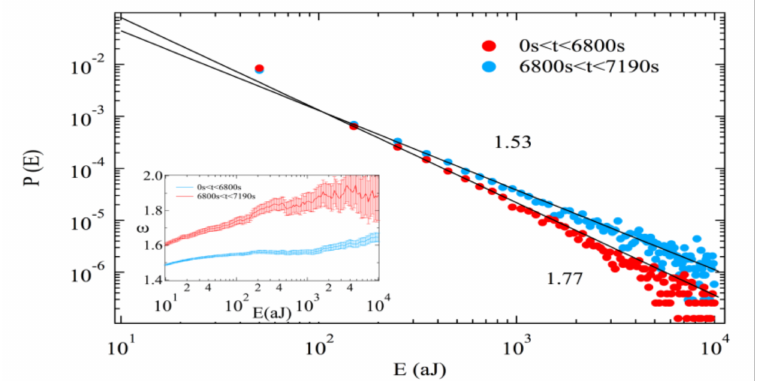
Figure 3. Distribution of avalanche energies for sandstone samples in the different time windows. The inset shows the maximum likelihood estimation fitting exponent ε as a function of a lower threshold. Reproduced with permission from [54]. De Gruyter,